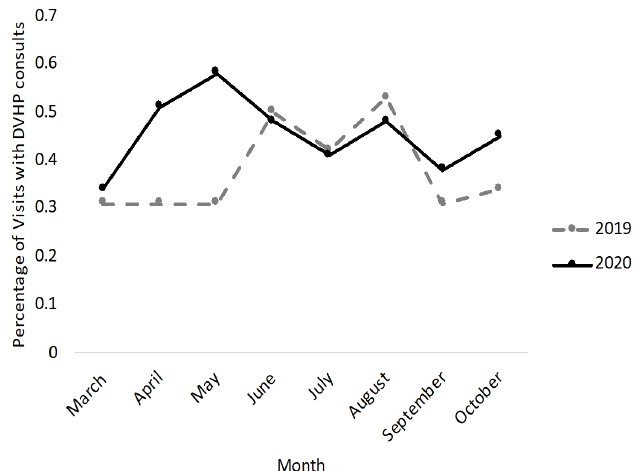
Figure 3. Percentage of emergency department visits with Domestic Violence Healthcare Project team consults